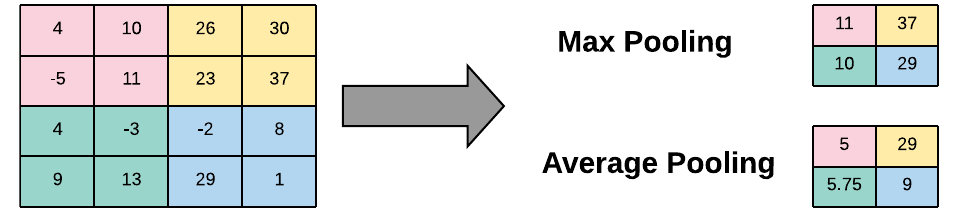
Figure 4. Graphic description of Max pooling and average pooling layer with a size of 2 ×